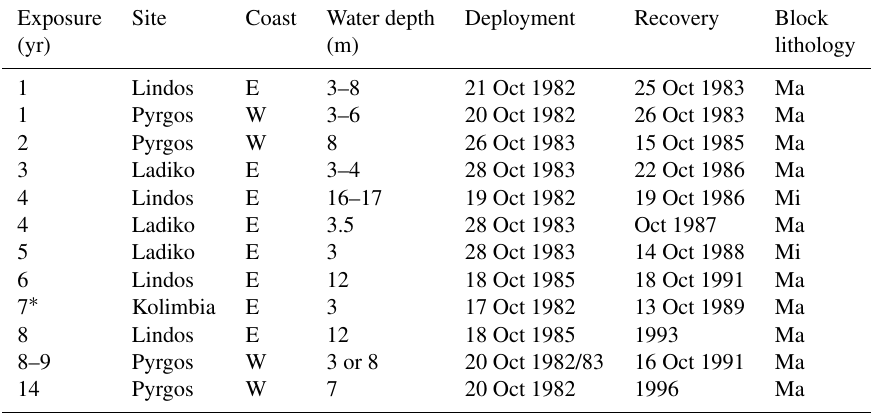
Table 1. Metadata of experimental blocks deployed during the experiment and analysed via micro-computed tomography (E is east, W is west, Ma is marble, Mi is micritic